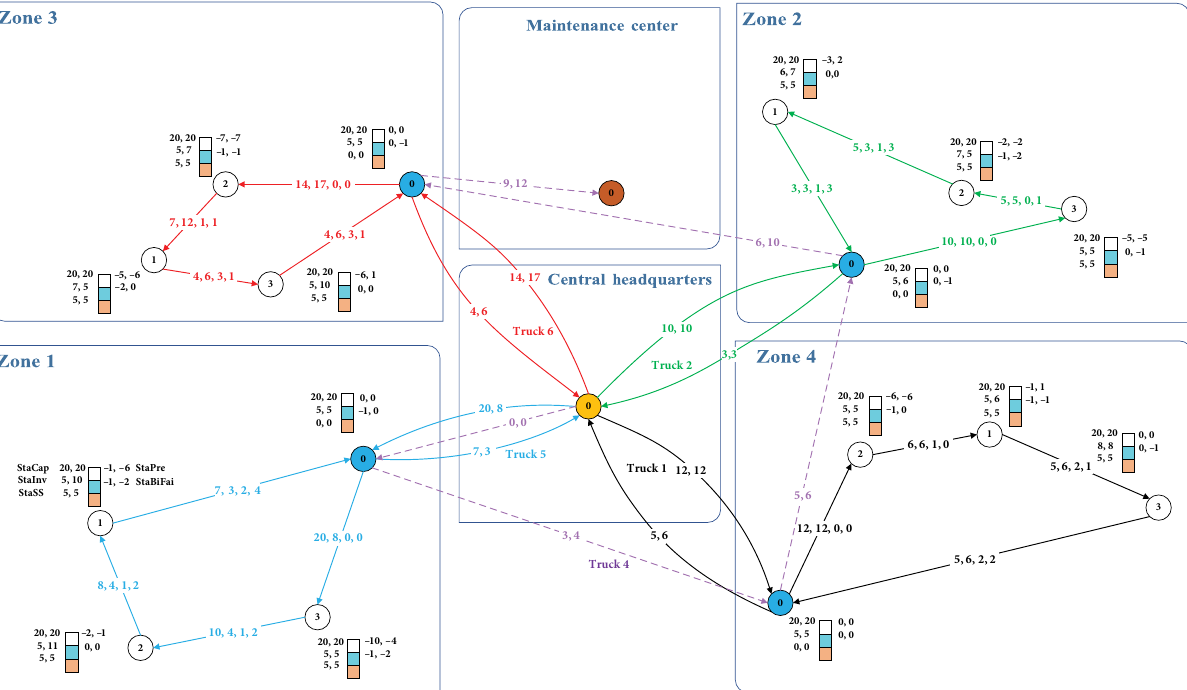
Figure 5. Result of solving by 50% reduction in capacity of